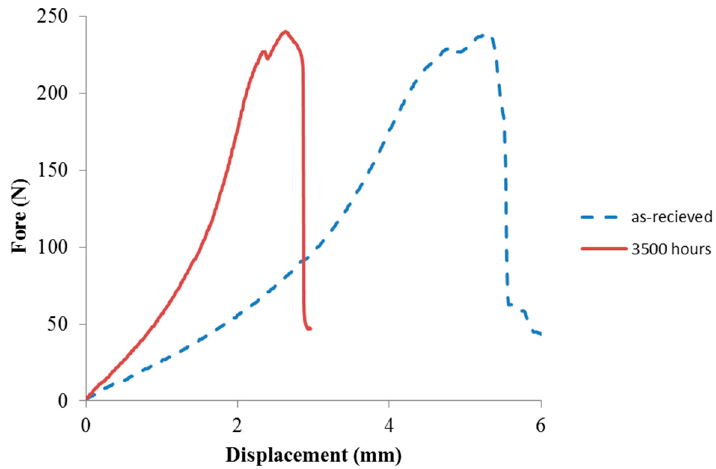
Figure 8. Force displacement curve for aged silicone in a salt bath at 100 ºC.